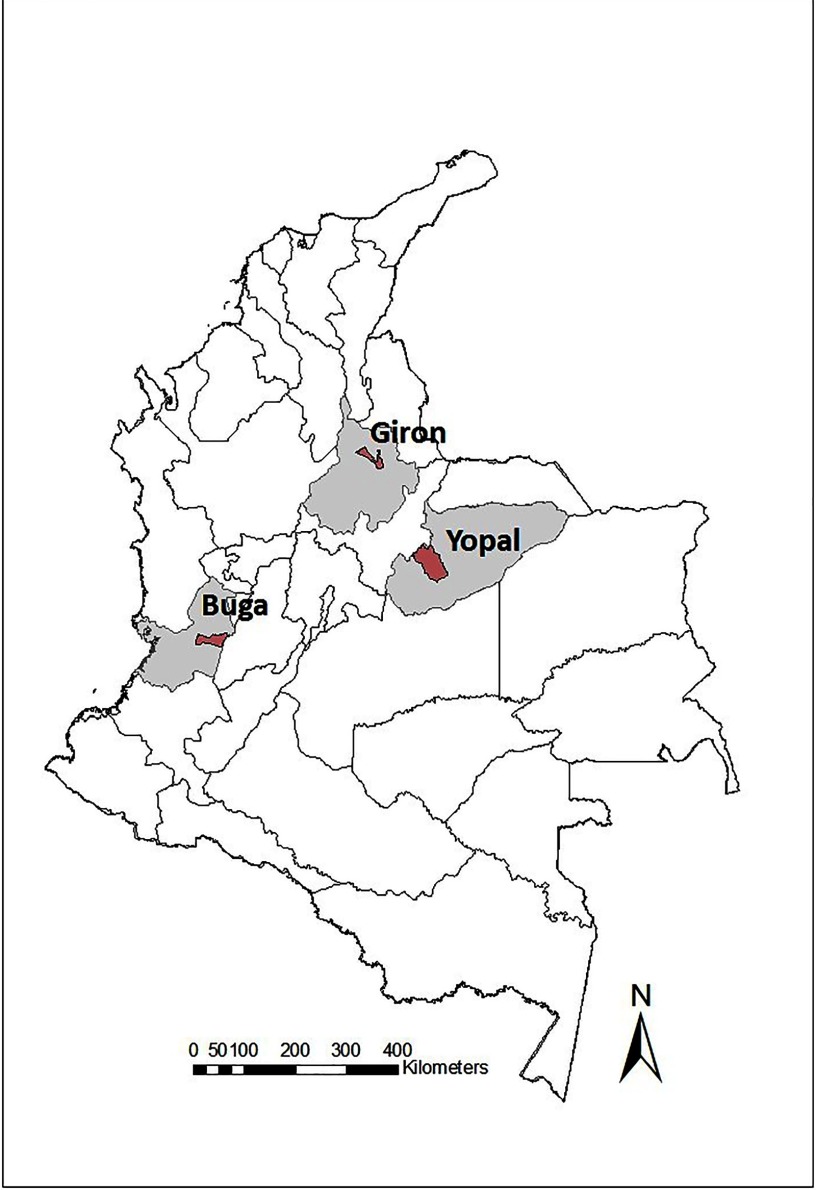
Departments (gray) and Municipalities (red) in Colombia participating in the Study, 2015–2018